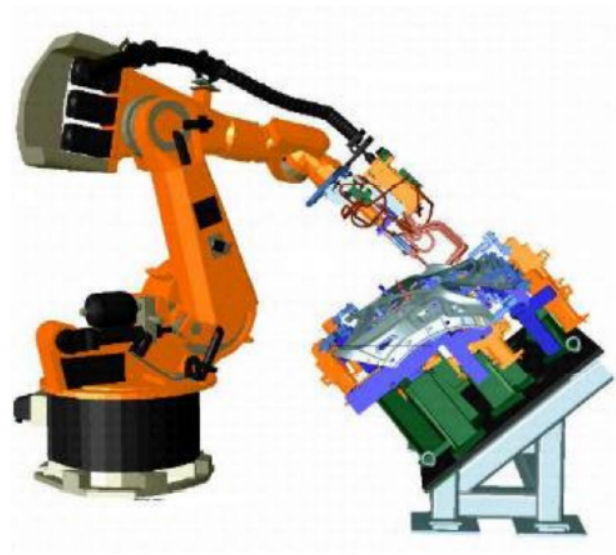
Figure 8. Welding